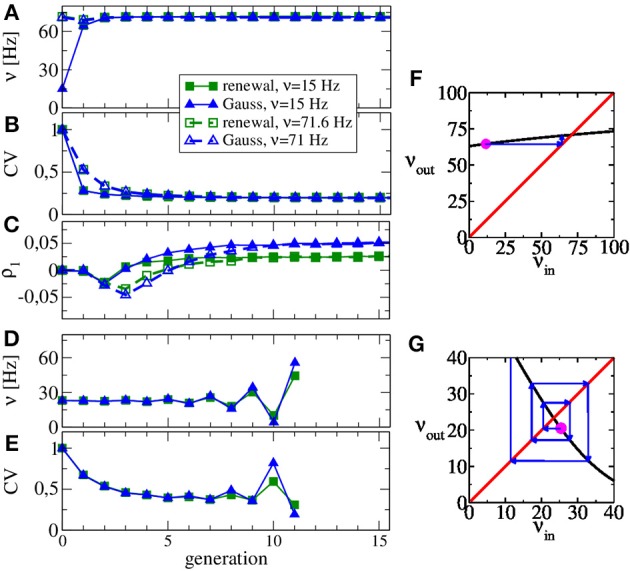
Evolution of ISI statistics over generations in stable (A,B,C,F) and unstable (D,E,G) regimes. Starting with Poissonian spike trains in the zeroth generation, the nth generation of the LIF neuron (n ≥ 1) receives noise input according to the statistics of the previous generation. Parameters as in Figure 2 yield the same stable rate (A) and CV (B) irrespective of whether the initial Poisson stimulation (zeroth generation) of the first generation (LIF neuron) is 15 or 71 Hz. The first serial correlation coefficient is positive for both procedures but differs in magnitude (C). Increasing the relative strength of inhibition to g = 5, our scheme is not stable anymore and both rate (D) and CV (E) oscillate as functions of the generation. Stability can be discussed in terms of the firing rate Equation 13 shown in (F,G) vs. input rate (black line) together with the identity line. In the regime of (A–C), the map from input rate to output rate (F) has a stable fixed point and small perturbations from it (magenta point) relax back into the fixed point (blue arrows). In the regime of (D–E), small perturbations are amplified (G), yielding an unstable fixed point.